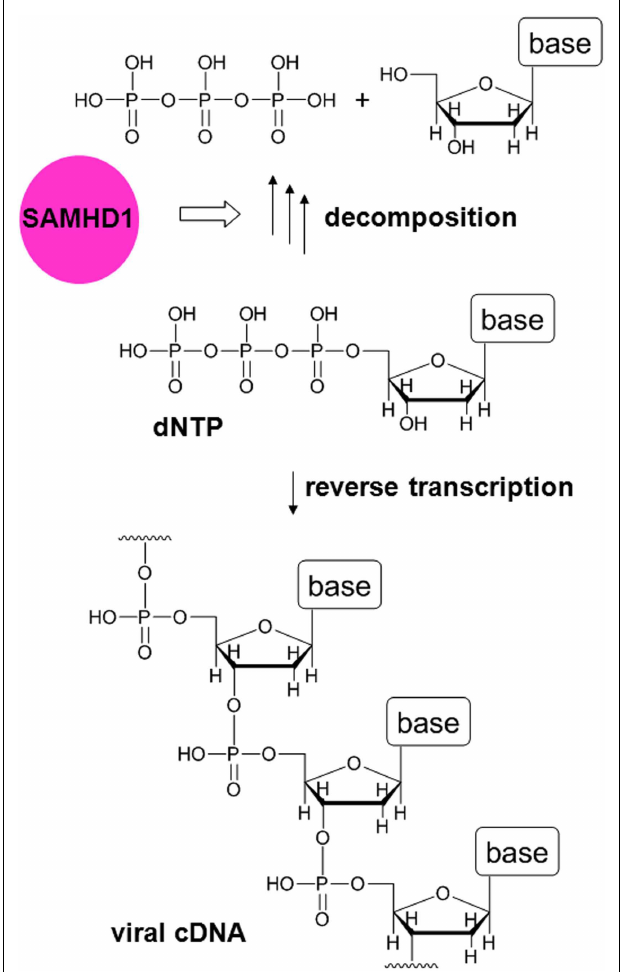
FIGURE 1 | Function of SAMHD1 in MDMs. In reverse transcription, viral cDNA is synthesized from dNTPs.The host restriction factor SAMHD1 is a dNTP triphosphohydrolase that degrades dNTPs.Thus, in the presence of SAMHD1, the concentration of dNTPs becomes low and reverse transcription is